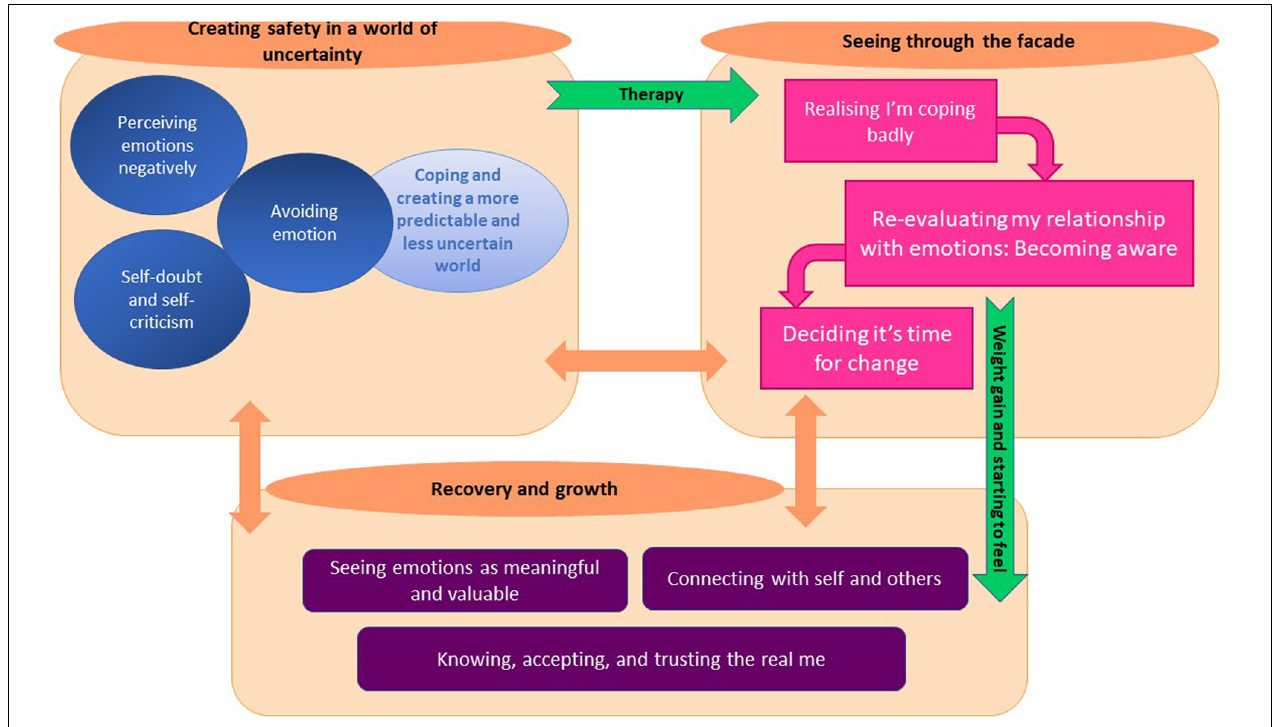
FIGURE 1 | Grounded theory of the change process in recovery from anorexia